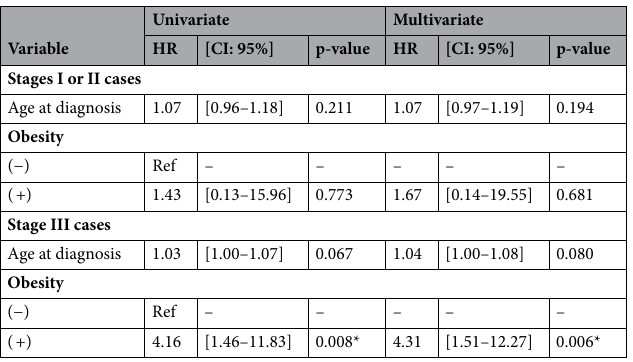
Table 3. Univariate and multivariate analyses of variables associated with survival by stage at diagnosis. * indicates p < 0.05